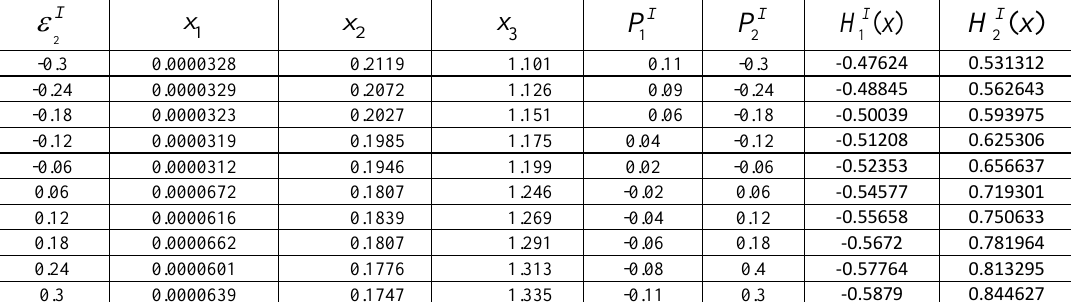
Table 4. Efficient solutions for the first level.